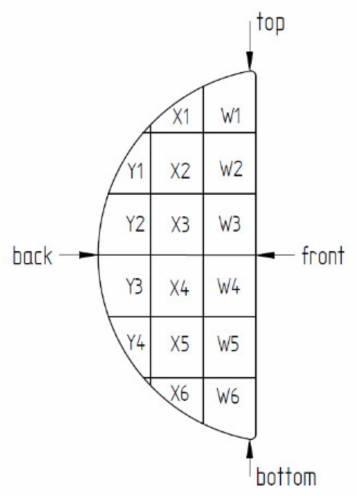
Figure 8. Cross-section of the briquette with the grid fields